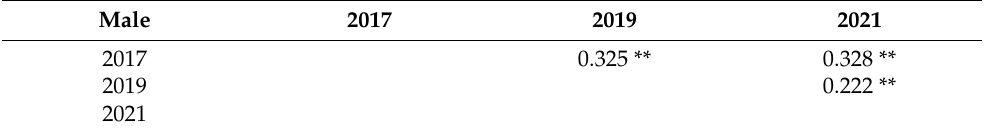
Table 5. The Spearman’s rank correlation coefficient of male strobilus productions between years based on pooling of families.